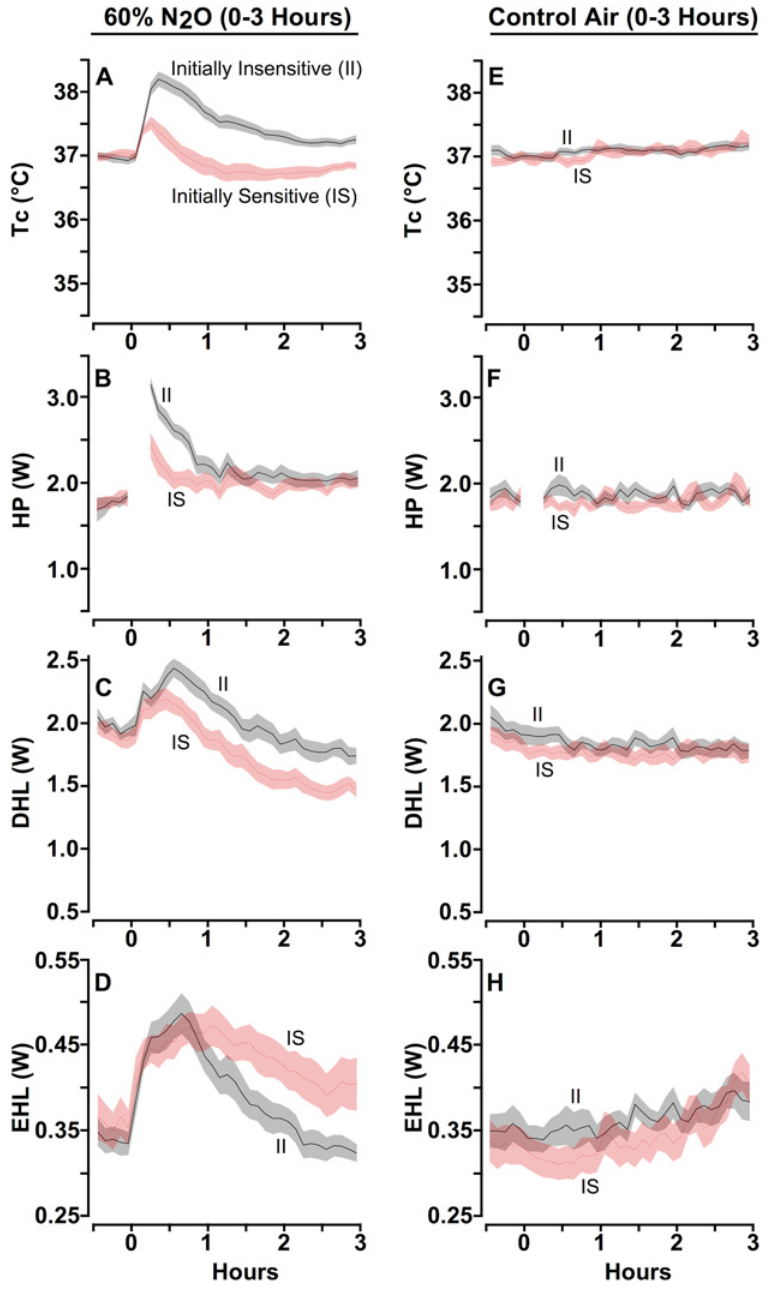
Fig 4. Final Calorimetric Assessment during a 60% N 2 O Administration for Initially Sensitive and Initially Insensitive Rats. A calorimetry retest conducted after the self-administration phase revealed that the IS and II groups both became frankly hyperthermic with the onset of 60% N 2 O administration but the magnitude was markedly greater and more persistent in the N 2 O self administration-prone II rats (A) due primarily to a greater HP response (B). The increases in DHL (C) and EHL (D) likely reflect a durable pharmacological effect of N 2 O in addition to the effect of increased body heat content to promote heat loss. The II and IS groups did not differ during the control gas session (E, F, G,